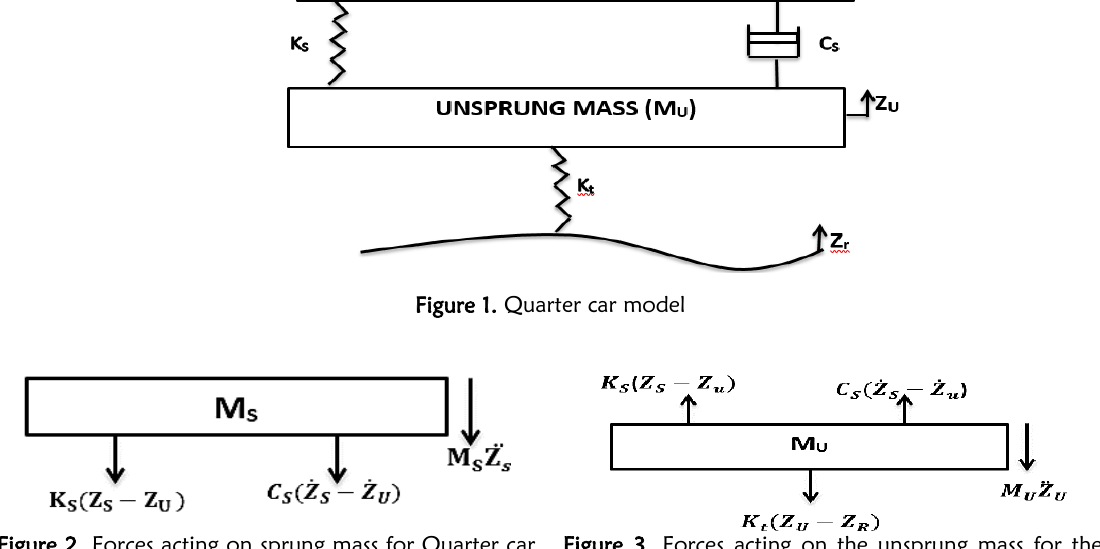
Figure 3. Forces acting on the unsprung mass for the Quarter car